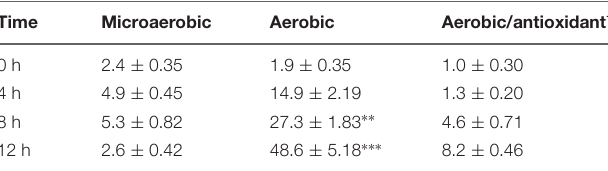
TABLE 2 | Formation of coccoidal Campylobacter jejuni under different oxygen conditions.